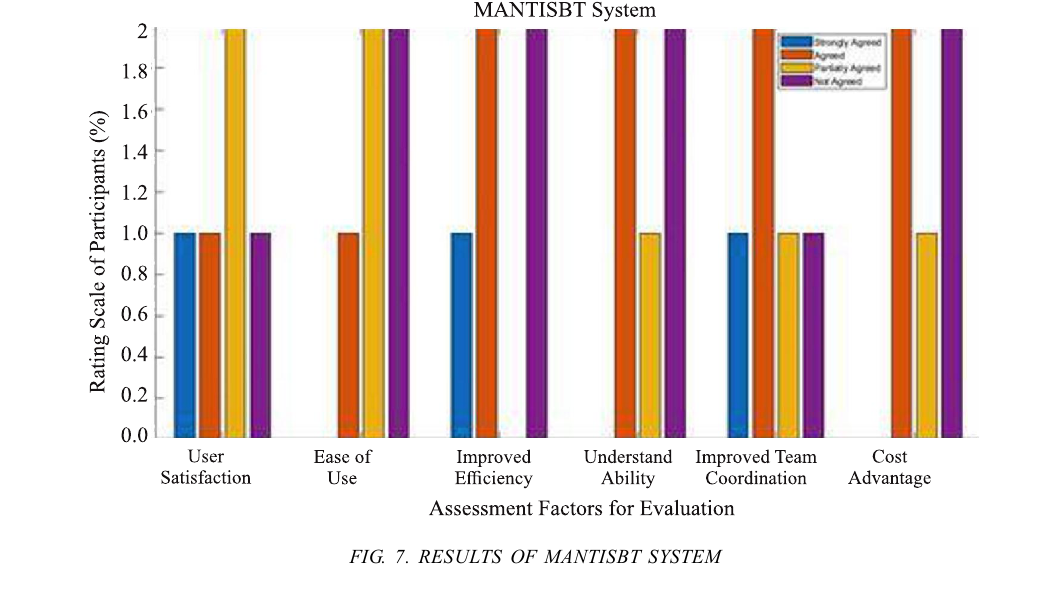
FIG. 7. RESULTS OF MANTISBT